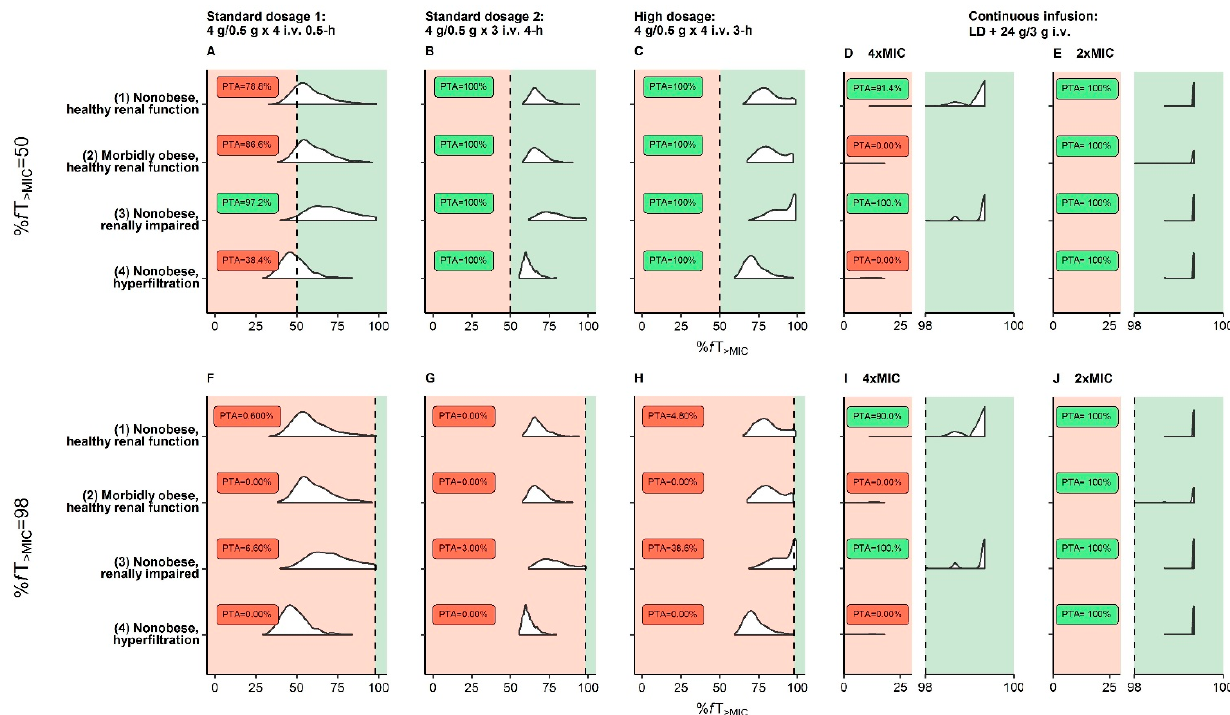
Figure 2. Probability of target attainment (PTA) based on the EUCAST species-independent resistance breakpoint (MIC = 16 mg/L) for virtual reference patients (see Table 1) receiving three dosing regimens recommended by EUCAST ( A / F , B / G , C / H ) and one continuous infusion dosing regimen ( D / E , I / J ). ( D / E , I / J ): Pharmacokinetic/pharmacodynamic targets related to 4×MIC or 2×MIC for the intervals % f T >MIC = 0–30 and % f T >MIC = 98–100 to allow discrimination between PTA curves <30% and >98%; vertical dashed black line: pharmacokinetic/pharmacodynamic targets (% f T >MIC = 50 or % f T >MIC = 98); PTA ≥ 90% (adequate therapy) labeled as green area and PTA < 90% (inadequate therapy) as red area. Abbreviations: % f T >MIC : Fraction of time that unbound concentrations exceed MIC over 24 h; EUCAST: European Committee on Antimicrobial Testing; i.v.: Intravenous; MIC: Minimum inhibitory concentration.